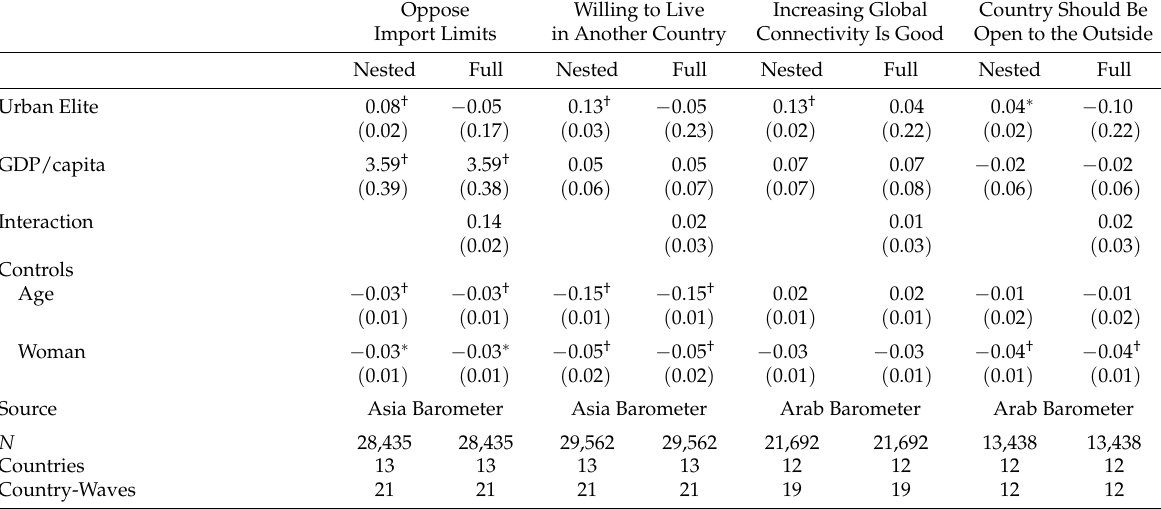
Table 2: Mixed-effects regression models on cooperative-internationalist attitudes (regional